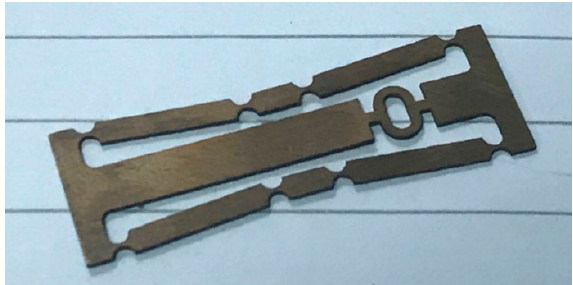
Figure 1. Real image of the designed sensor.